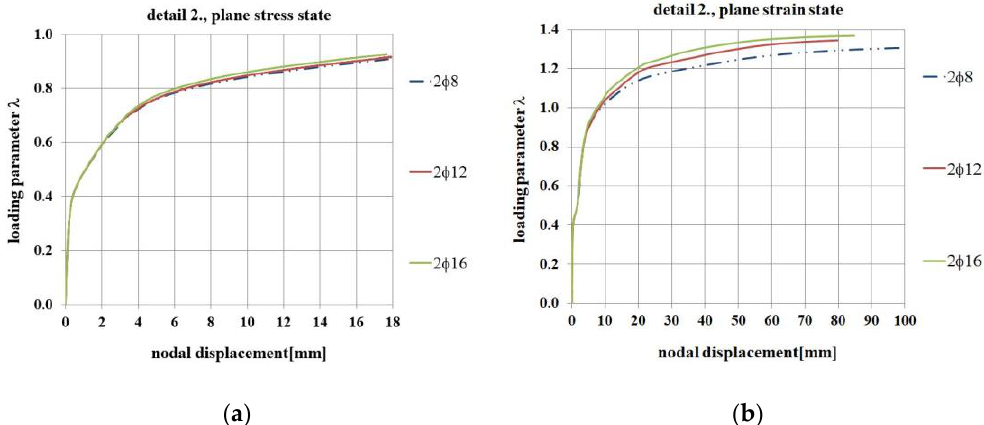
Figure 28. Nodal displacement vs. loading parameter for different diagonal reinforcement areas, ( a ) in the plane stress state, ( b ) in the plane strain state.